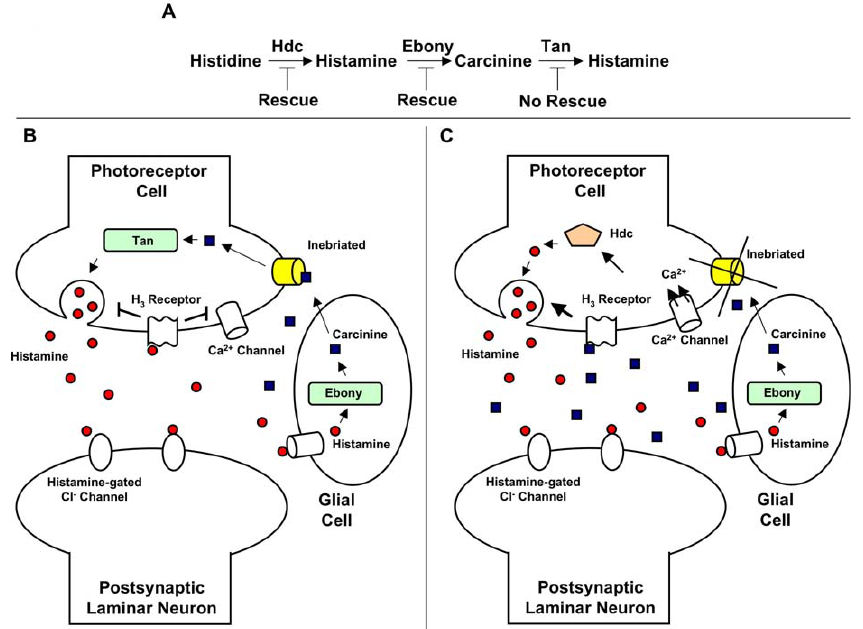
Figure 6. Possible Role of Inebriated in Retinal Signal Transduction in Drosophila (A) Epistatic diagram illustrating how mutations in either Hdc or ebony , but not tan , rescue ine 2 -associated oscillations. (B) Model of histamine/carcinine dynamics in a wild-type Drosophila eye. In a wild-type fly eye, the photoreceptor cell depolarizes in response to light, resulting in a release of histamine into the synaptic cleft. This histamine then binds to and activates postsynaptic histamine-gated chloride channels on laminar neurons, thereby perpetuating the light-induced signaling cascade in the eye. Excess histamine can bind to a putative presynaptic H 3 receptor resulting in the inhibition of calcium influx and further release of neurotransmitter. Eventually the majority of the histamine is removed from the synaptic cleft by glial cells, where it is converted into carcinine by the enzyme ebony. Carcinine is then taken up by photoreceptor cells, by means of the inebriated neurotransmitter transporter, where it is converted back into histamine by the enzyme tan. (C) Model of histamine/carcinine dynamics in an ine -mutant Drosophila eye. In ine mutants the release of histamine by photoreceptor cells, the uptake of histamine by glial cells, and the conversion of histamine into carcinine are all unaffected. However, the removal of carcinine from the synaptic cleft is presumed defective. This results in an excess of carcinine in the synaptic cleft, which then binds to the putative H 3 receptor permitting calcium entry, ultimately stimulating the production and release of histamine from the photoreceptor cell. The newly released histamine and excess carcinine compete for binding to the H 3 receptor, resulting in a fluctuation between inhibition and liberation of calcium channels, ultimately producing the repolarization/depolarization responses that collectively contribute to the observed oscillations seen in ine mutant ERGs.